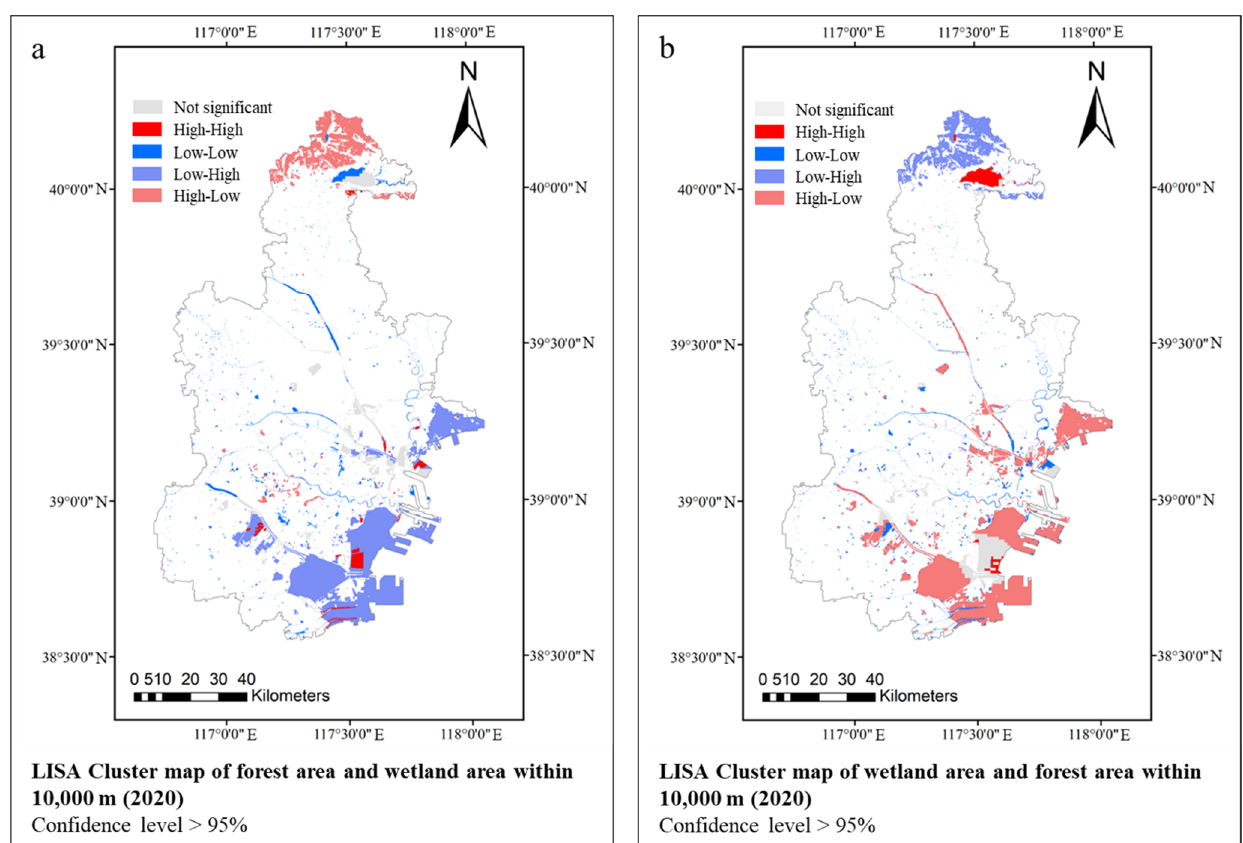
Figure 8. LISA Cluster map of forest area and wetland area within 10,000 m in Tianjin (2020) ( a ), LISA Cluster map of wetland area and forest area within 10,000 m in Tianjin (2020) ( b ).